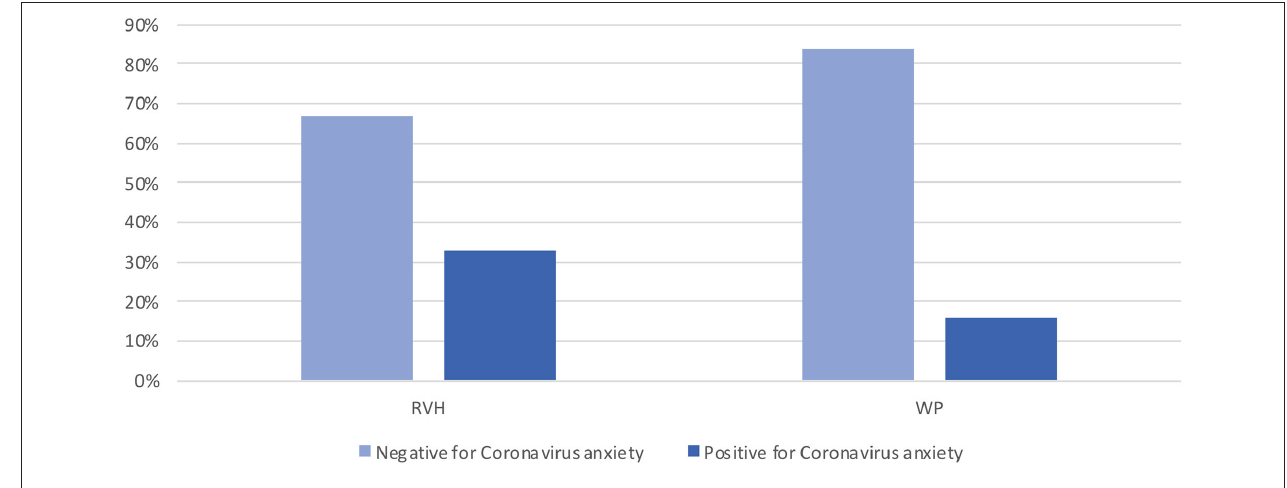
FIGURE 1 | CAS scores by site.